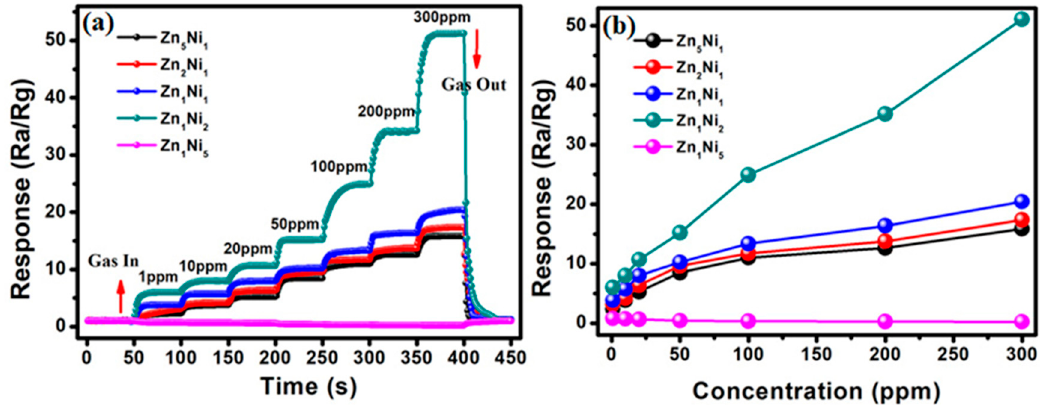
Figure 7. ( a ) Dynamic response of as-developed 3D n -ZnO / p -NiO based sensors toward high NH 3 concentration (1–300 ppm) at 280 ◦ C. ( b ) Gas responses vs. NH 3 concentrations curves of ZnO / NiO sensors.